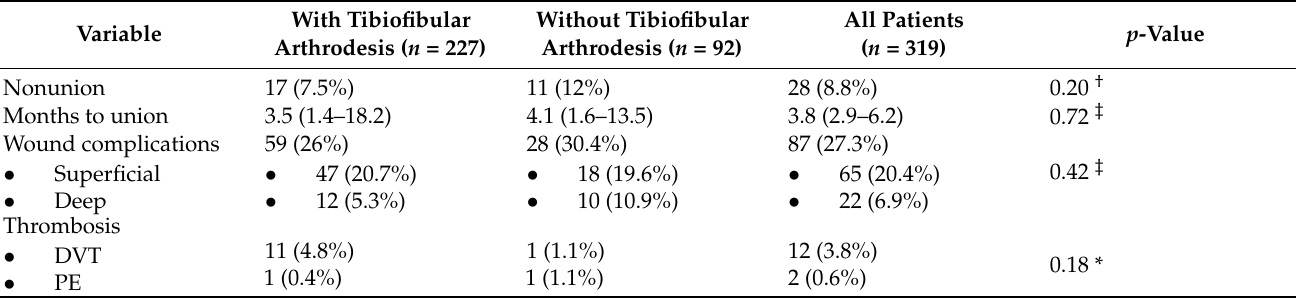
Table 7. Outcomes.